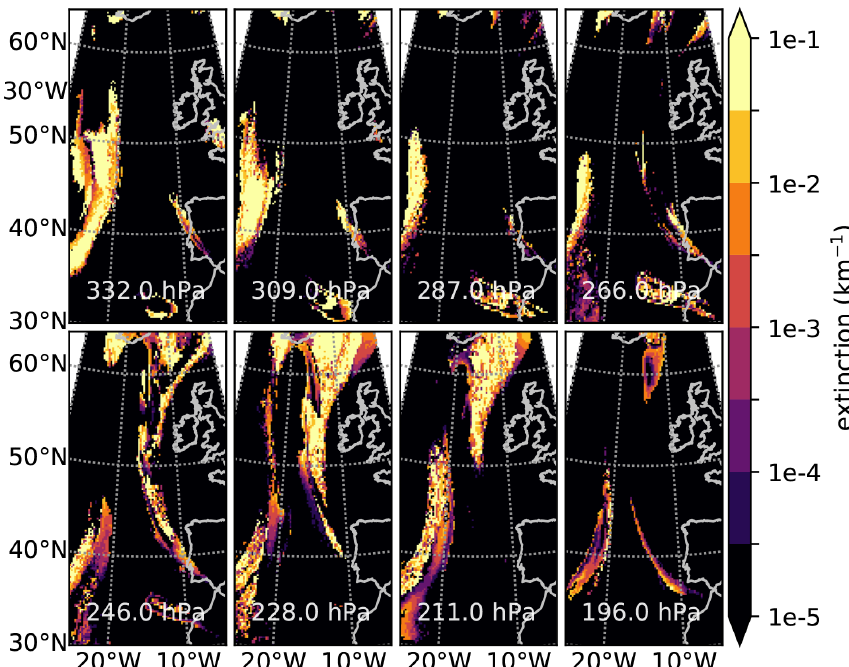
Figure 7. Extinction of a cirrus cloud simulated by CLaMS-ICE and computed from ice water content and particle radii.